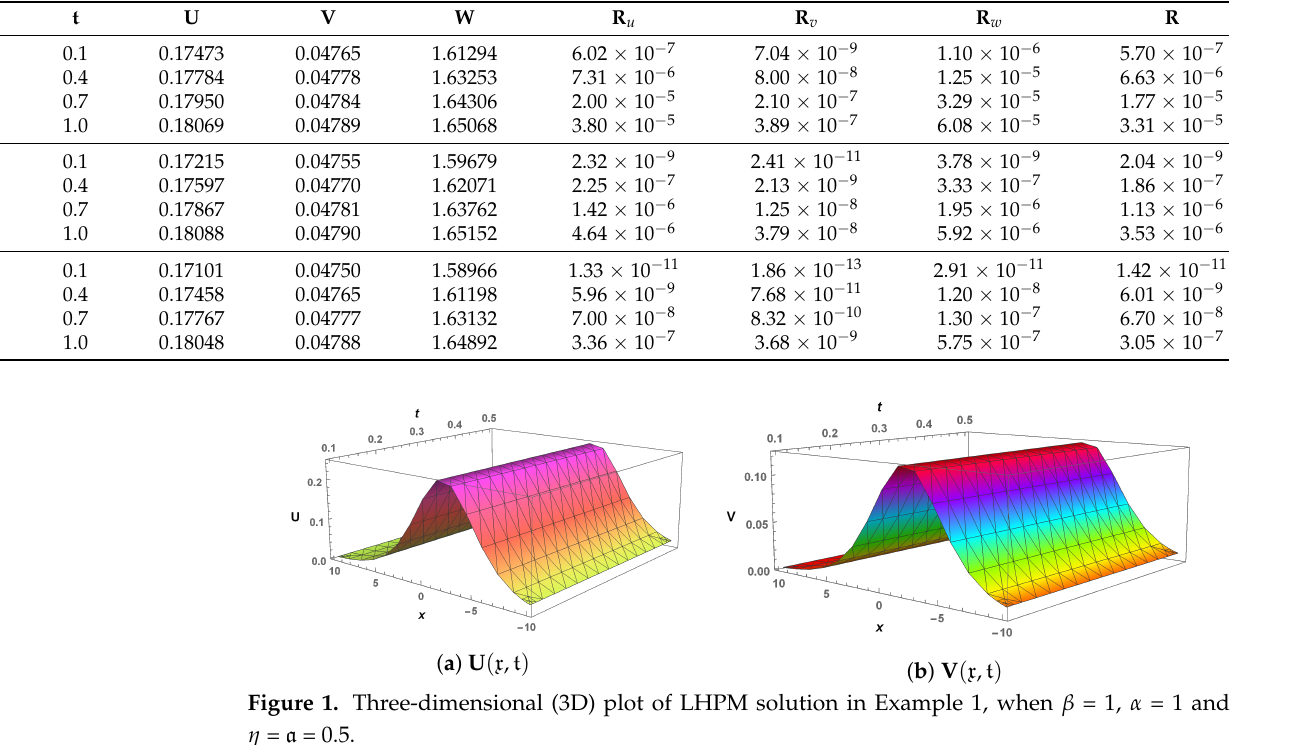
Table 6. LHPM solutions and errors at different values of fractional parameter β in Example 3 when α = 0.2, x = 5, c 0 = c 2 = 1 and p = 0.55 (where R u , R v , R w and R represent residual errors of U , V , W and system error, respectively).